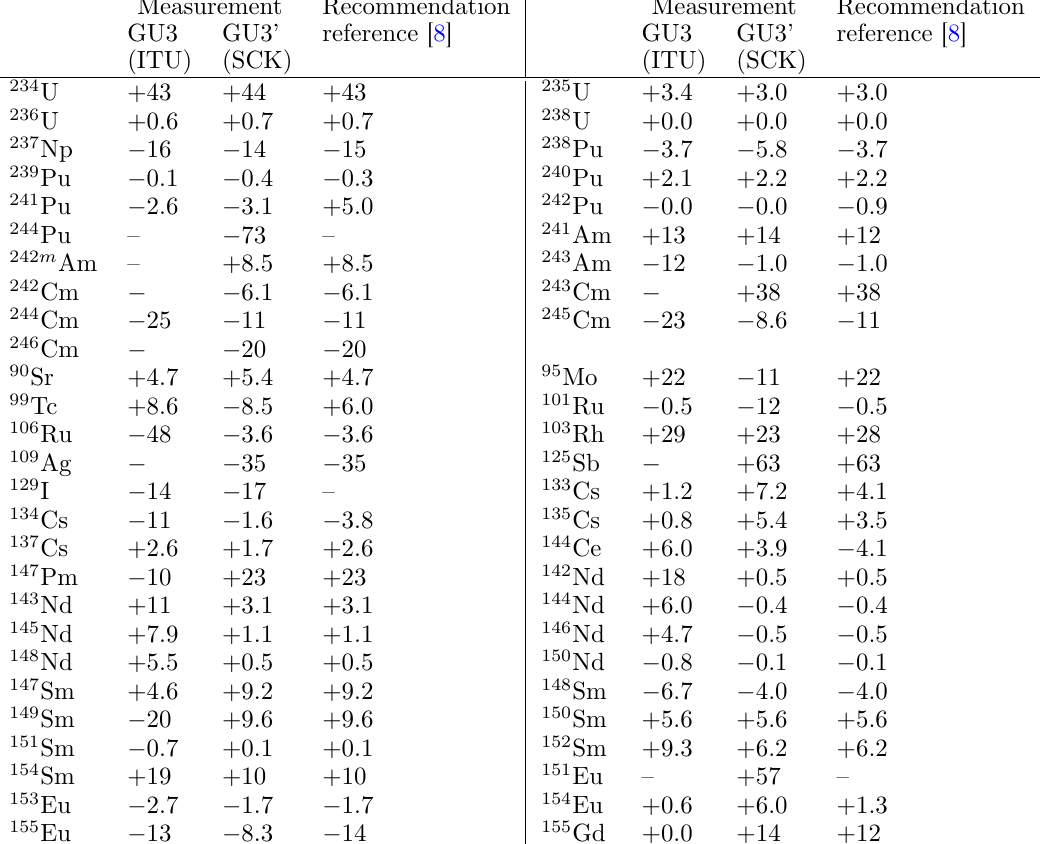
Table B.1. Nominal C/E-1 values and experimental uncertainties in% (as one standard deviation) for the GU3 and GU3’ samples. Calculations are performed with CASMO5 version 2.03 and the e7r1.201.586.bin library, except for